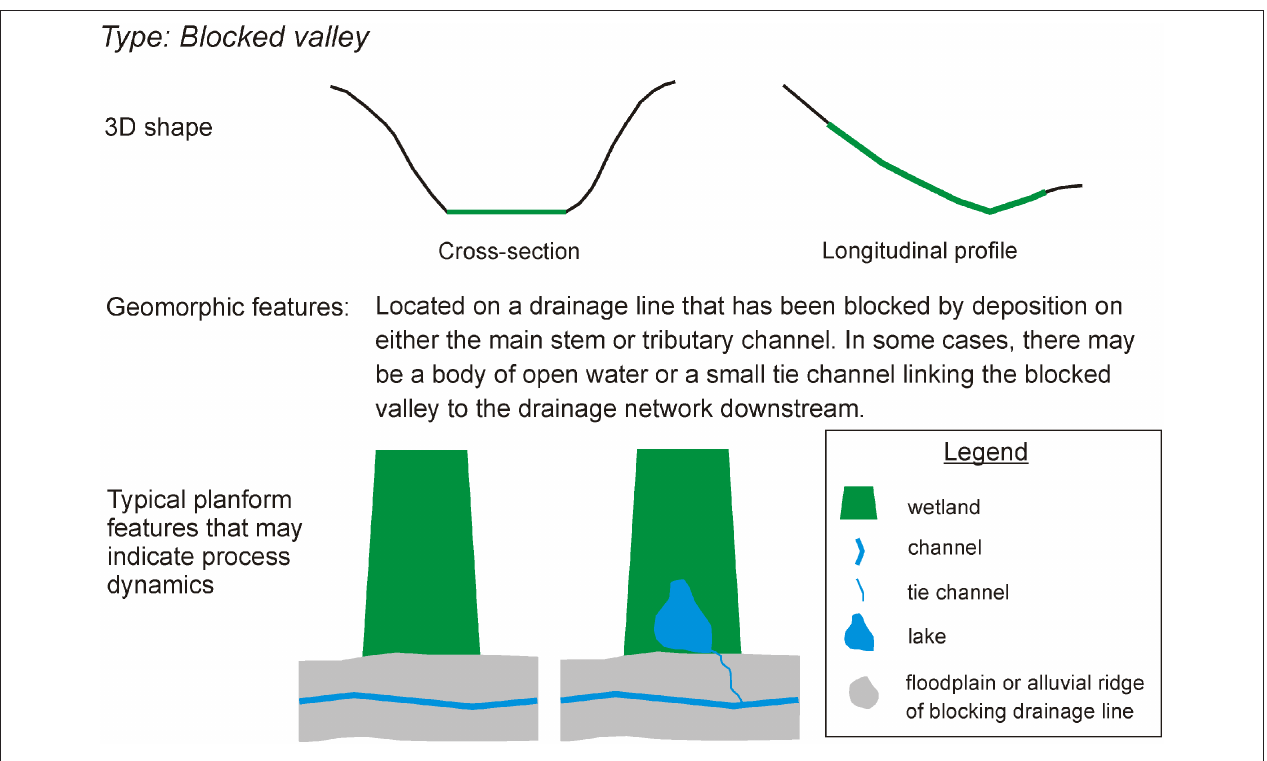
FIGURE 5 | Schematic shape and geomorphic features that are used to classify blocked-valley wetland type, followed by typical planform features that may or may not occur.